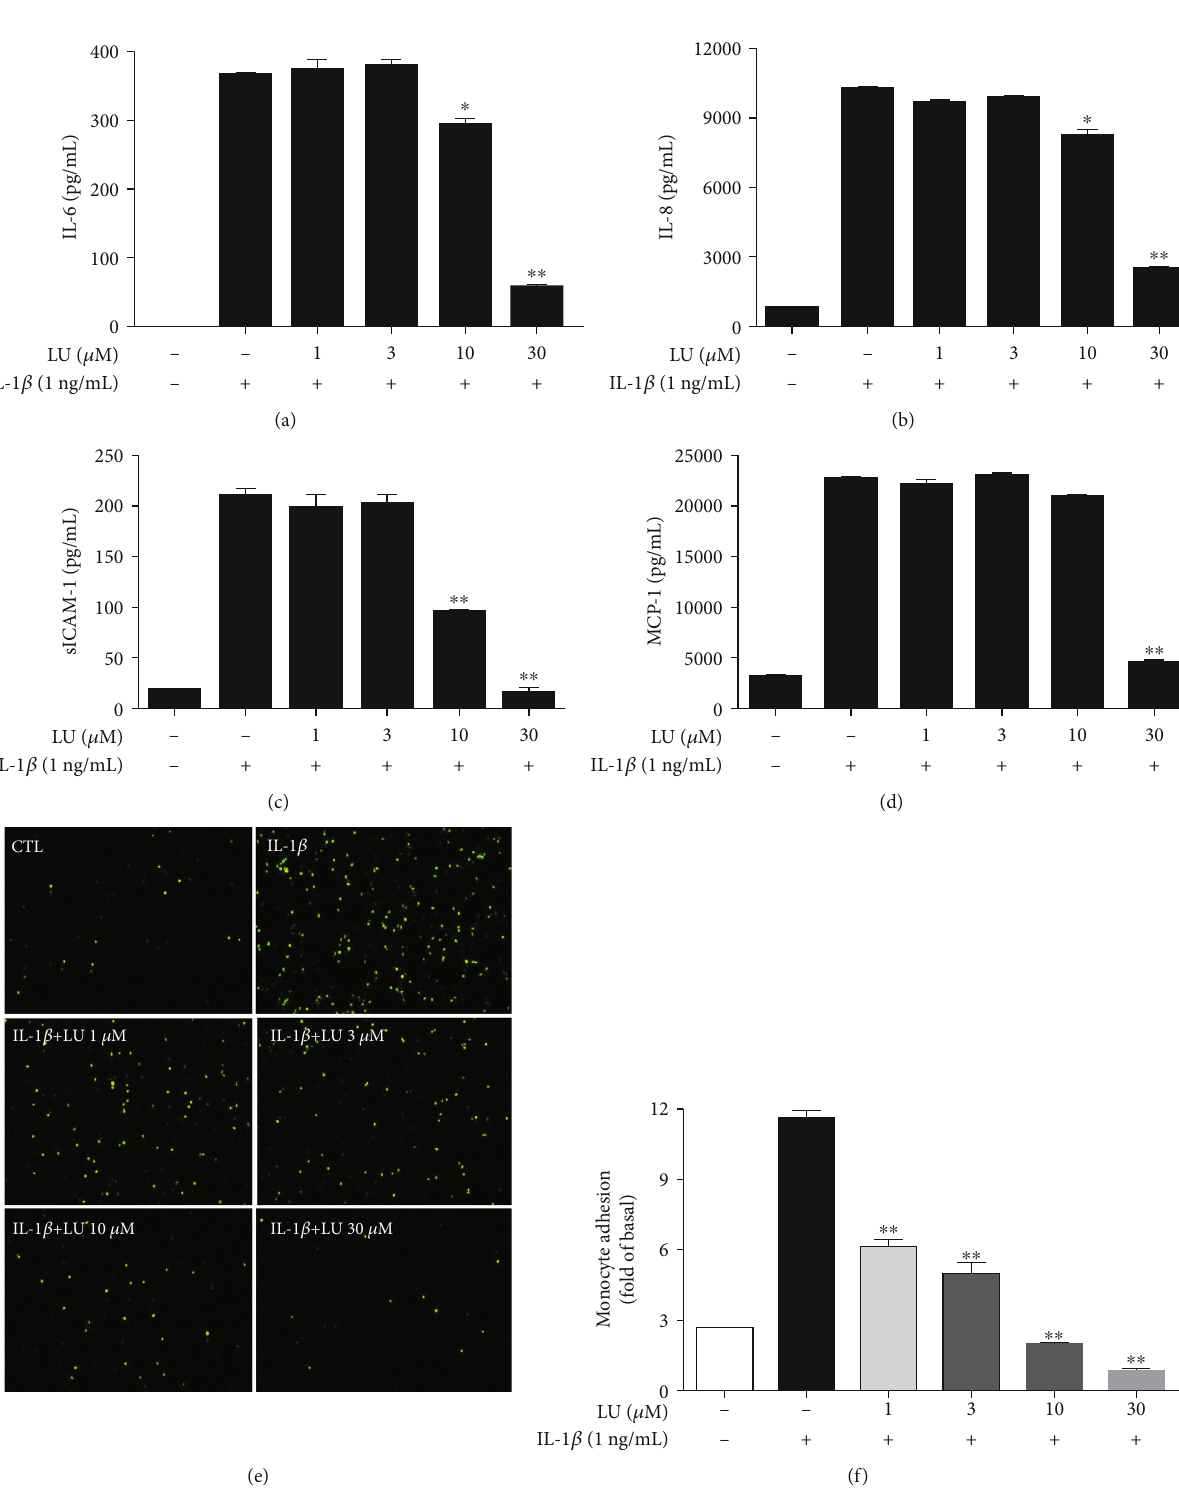
Figure 3: Luteolin inhibited in fl ammation-related cytokine expression and attenuated THP-1 cell adherence to IL-1 β -stimulated ARPE-19 cells. Cells were pretreated with di ff erent doses of luteolin (LU) and then incubated with IL-1 β (1 ng/mL) for 24 h. ELISA results showed the levels of (a) IL-6, (b) IL-8, (c) sICAM-1, and (d) MCP-1. (e) LU signi fi cantly suppressed THP-1 cell adherence to IL-1 β -stimulated ARPE-19 cells. Fluorescent-labeled THP-1 cells (green) were cocultured with control (CTL) or IL-1 β -stimulated ARPE-19 cells in the absence or presence of the indicated LU concentrations. (f) The fl uorescence intensity revealed THP-1 cell adhesion to IL-1 β -stimulated ARPE-19 cells, which was used to quantify calcein-AM fl uorescence. The data represent the mean ± SD . ∗ p < 0 : 05 , ∗∗ p < 0 : 01 , compared to ARPE-19 cells stimulated with IL-1 β